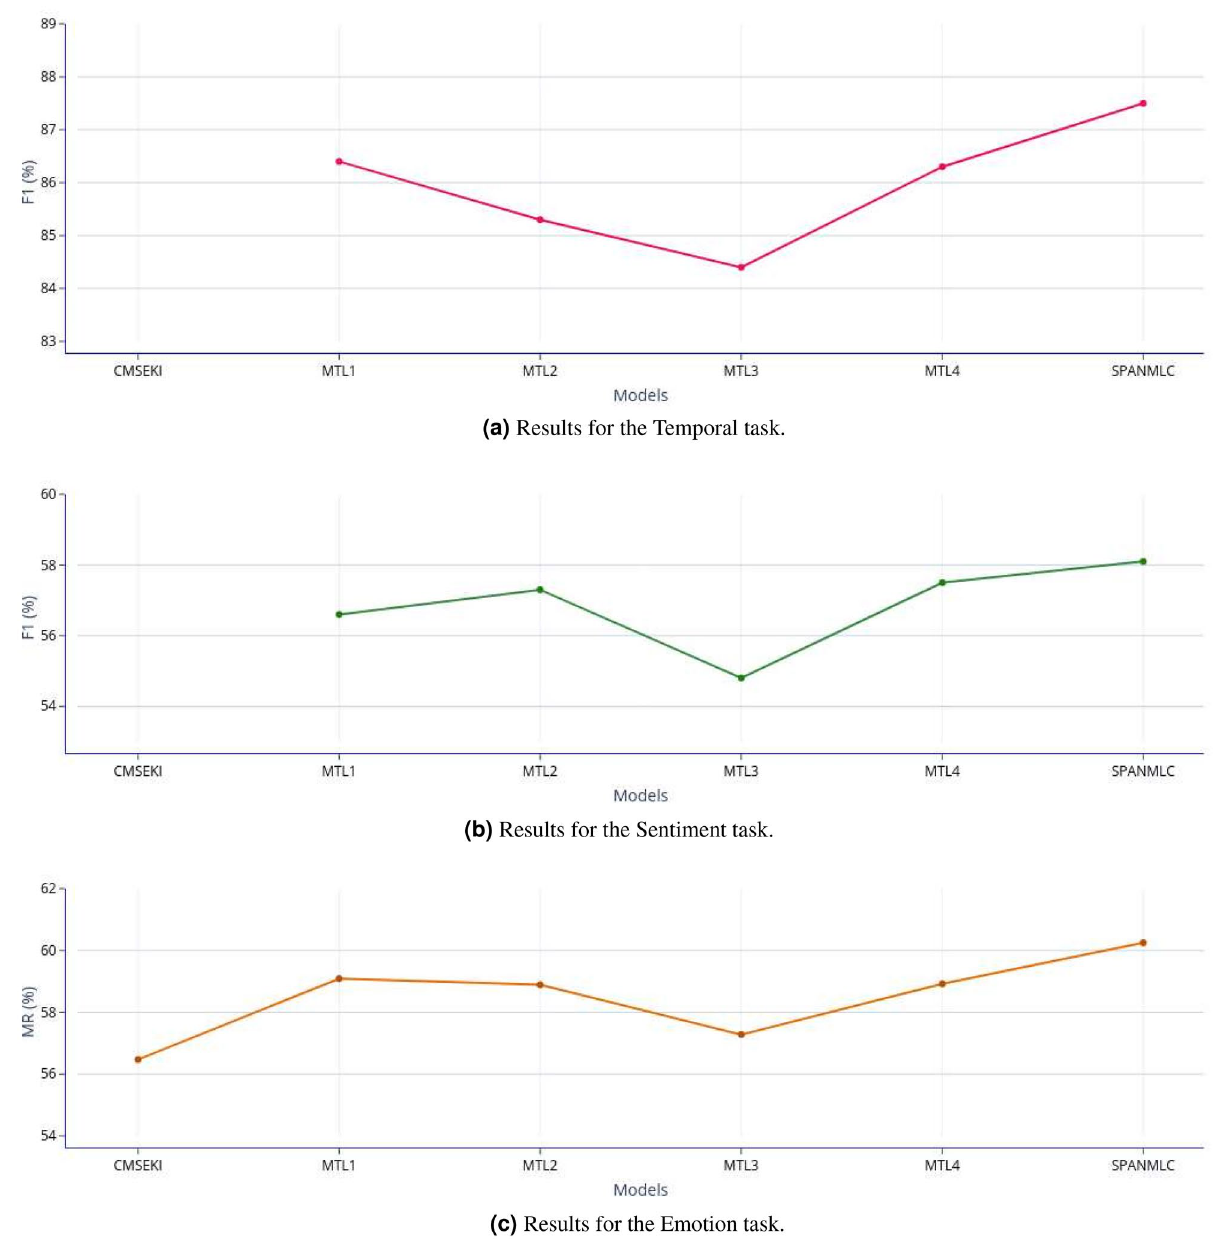
Figure 6. Graphical depiction of the scores from the various multitask learning (MTL) baselines and the proposed SPANMLC